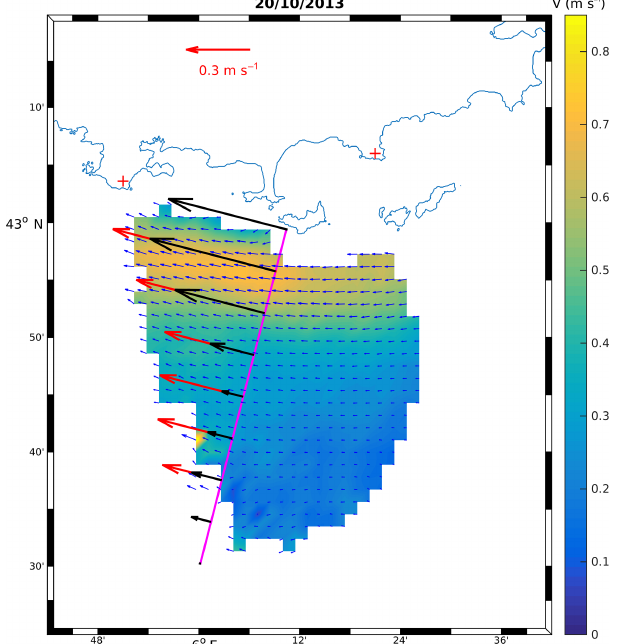
Figure 10. HF radar surface currents near Toulon for one date (20 October 2013); direction with small arrows, current speed is in colour. SARAL track 302 is marked in pink; 1Hz cross-track geostrophic currents from SARAL altimetry are in black; the HF radar total currents projected in the altimetric cross-track direction are in red. The current scale of 0.3ms − 1 is associated with the pro- jected currents. Positions of the two HF radar sites are marked with the red crosses on